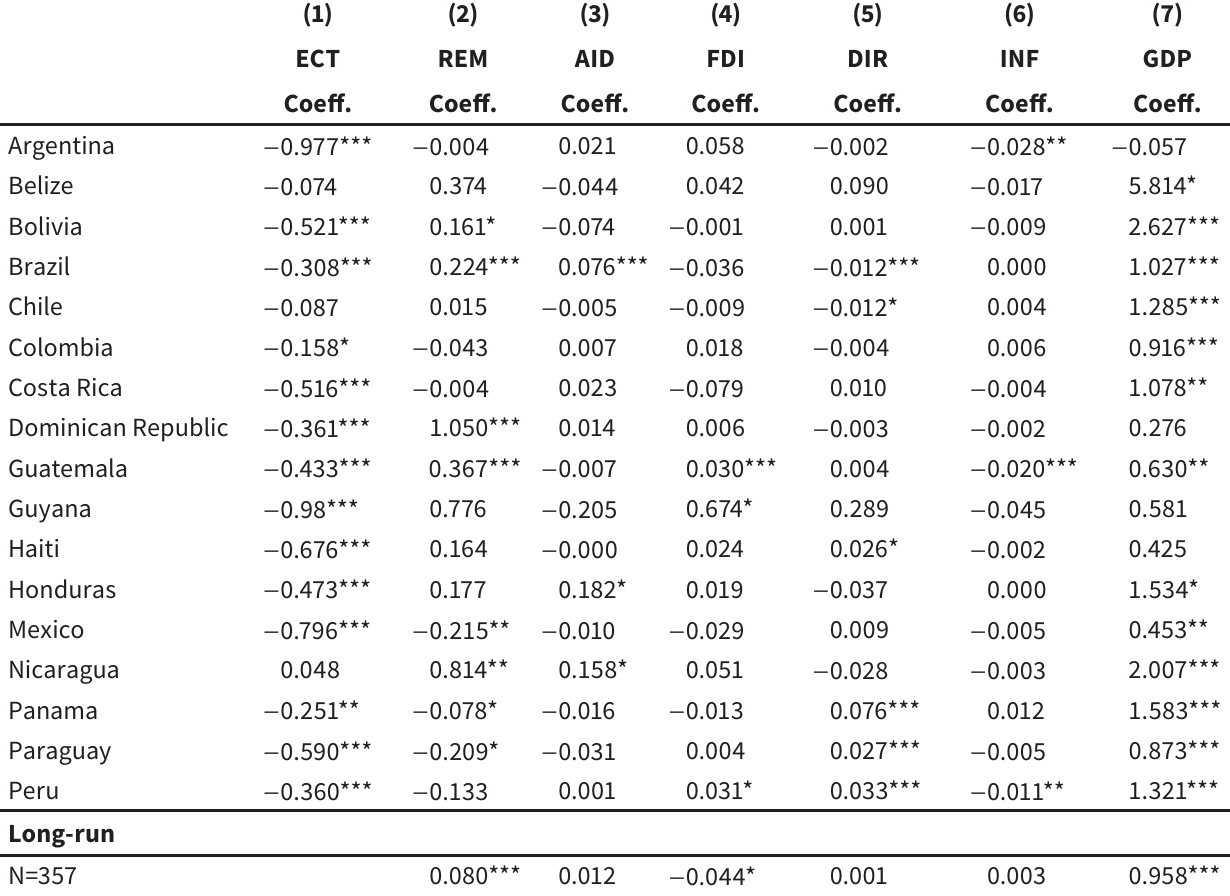
Remittances and savings – PMG results for full sample (individual countries) –